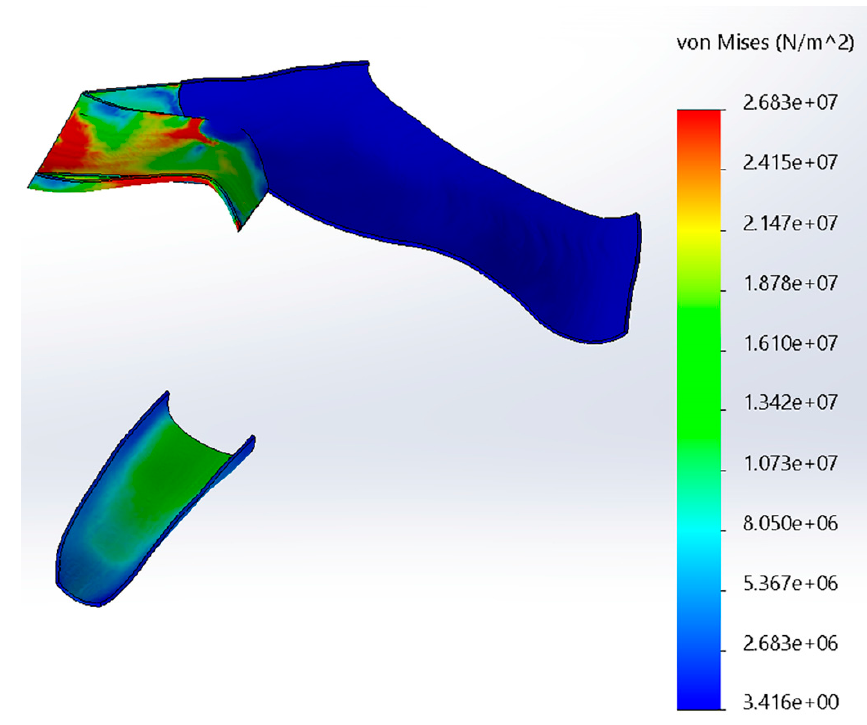
Figure 11. Stress distribution along the forefinger and thumb orthoses.